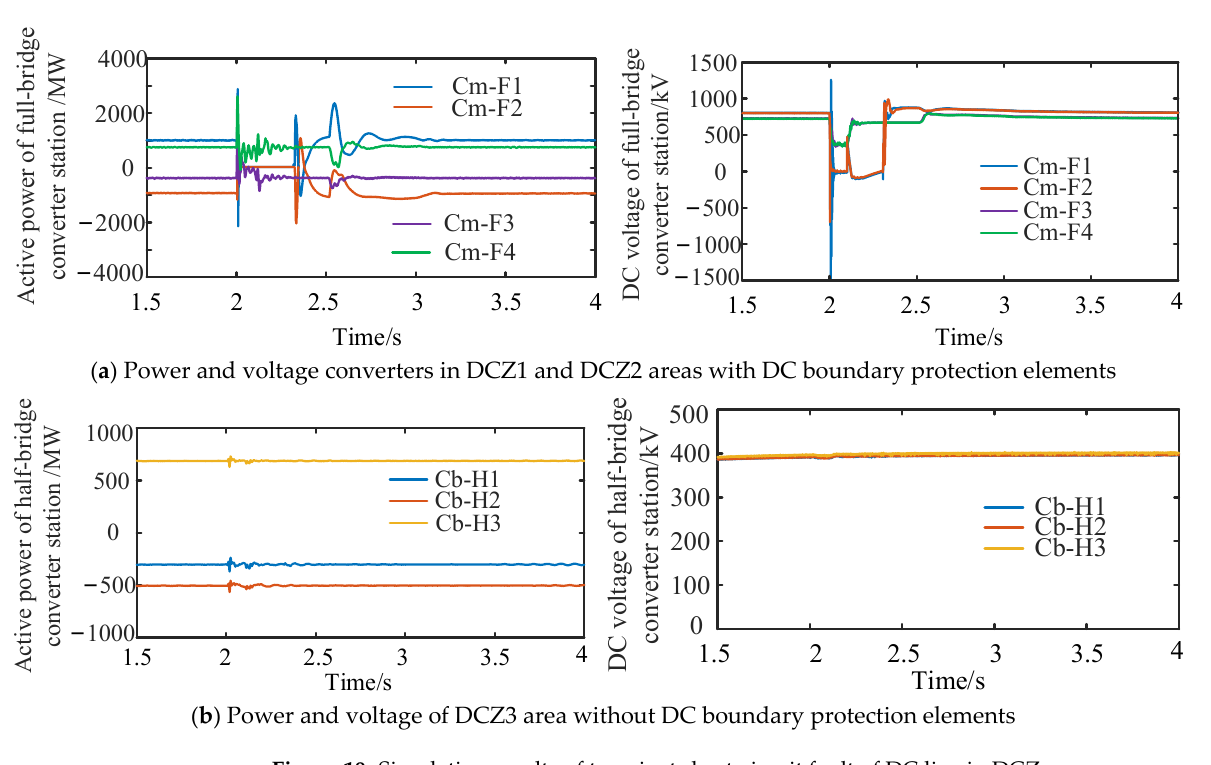
Figure 19. Simulation results of transient short ‐ circuit fault of DC line in DCZ 1 .